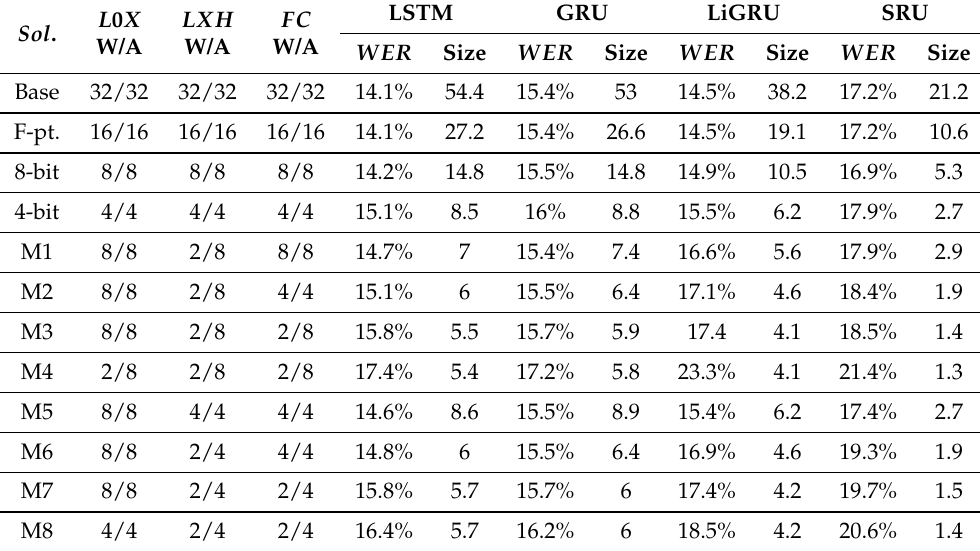
Table 2. The result of applying post-training quantization on the LSTM-, GRU-, LiGRU-, and SRU- based models. The first row is for the baseline model size and error rate. The second four rows are for non-mixed quantization. The last group of rows are for selected mixed quantizations with integer precisions. L 0 x is the precision of first-layer input computations, while LXH is the precision of the rest of the layers’ input and recurrent (projection is SRU case) computations. FC is the precision of the FC layer. W / A denotes weight and activation precision. For each quantization configuration, we show the WER , size. Sol